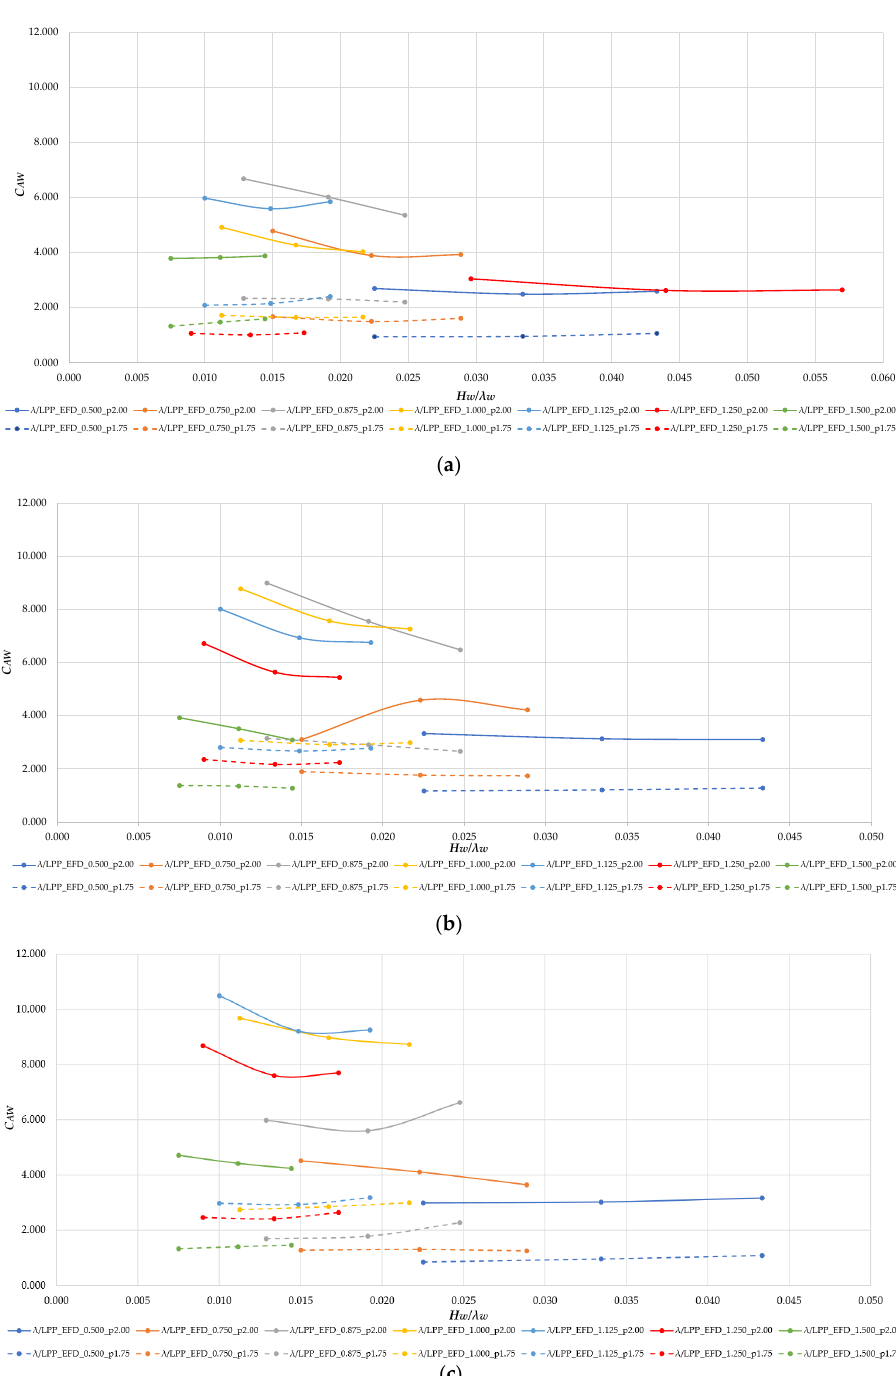
Figure 11. EFD results, steepness effect for each speed: ( a ) 𝐹 𝑅 = 0.131; ( b ) 𝐹 𝑅 = 0.174; ( c ) 𝐹 𝑅 = 0.218.